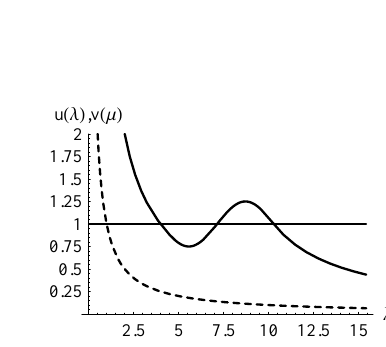
Figure 11. Fučík problem spectrum. Figure 12. Functions U (1 ,λ ) (solid line) and V (1 , µ ) (dashed